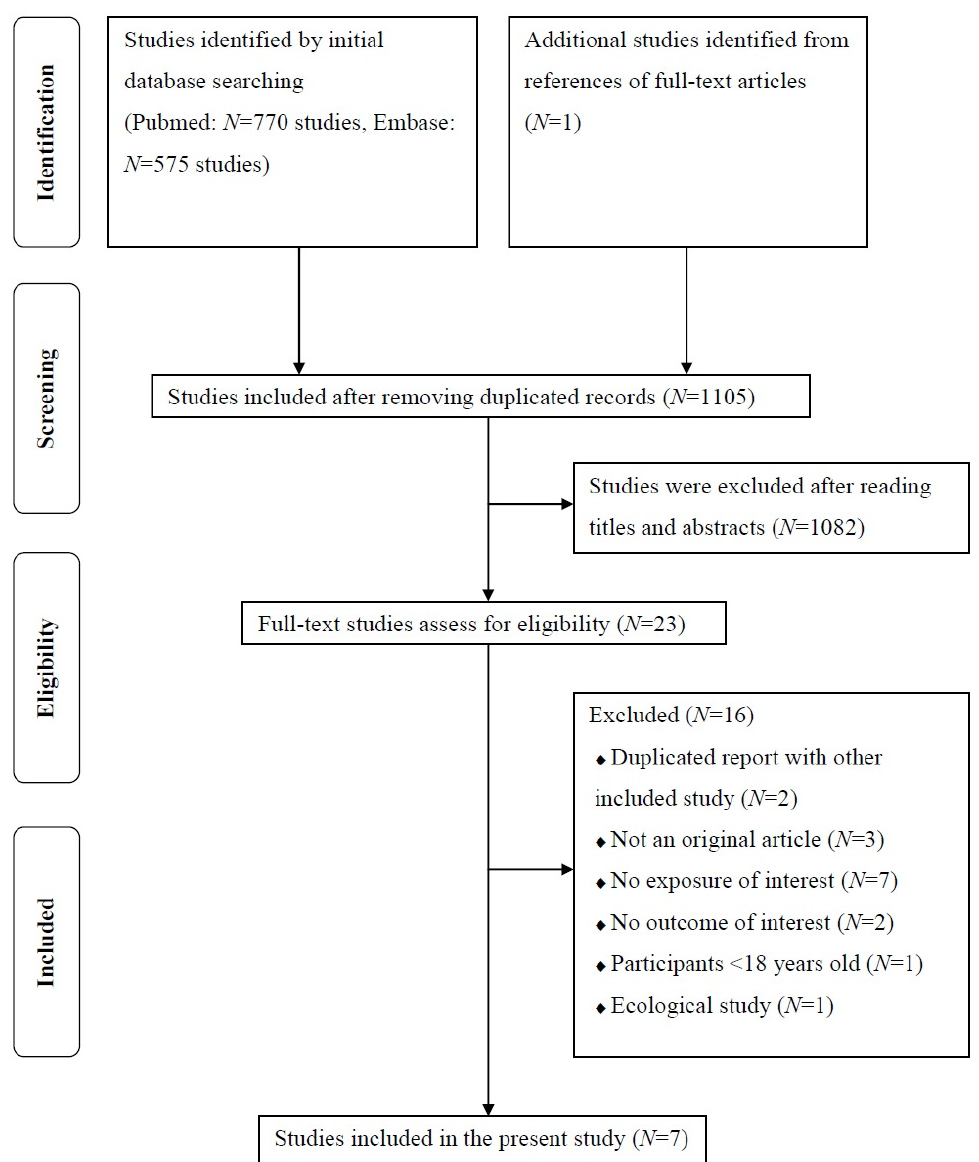
Figure 1. Flow diagram of articles included in the present study.